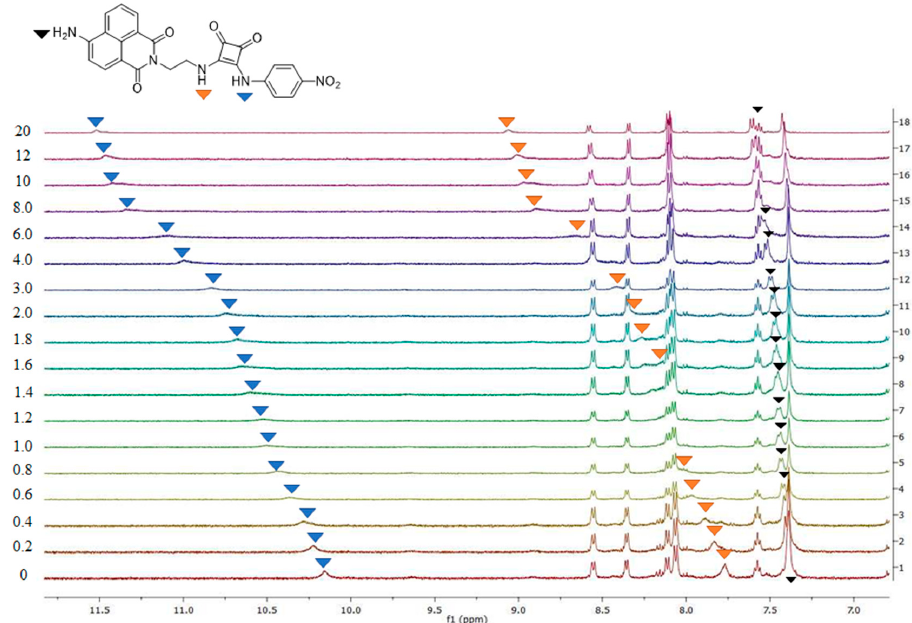
Figure 6. Changes in the 1 H NMR spectrum (NH a , NH b , NH c identified) of SN2 upon the addition 0–20 equivalents of anions as tetrabutylammonium (TBA) chloride in DMSO-d 6 .